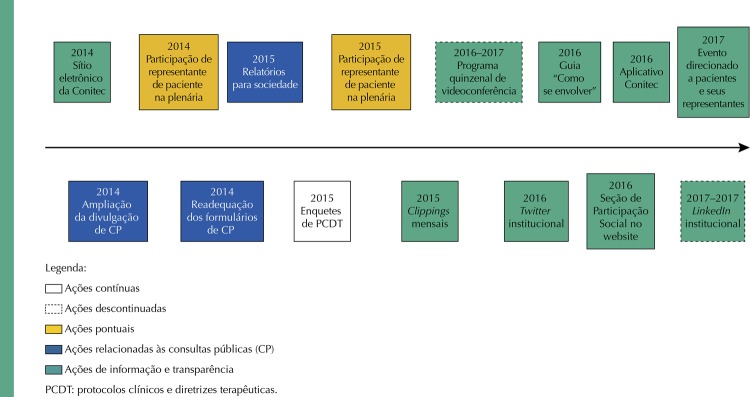
Linha do tempo das ações de envolvimento do público e do paciente nos processos de avaliação e incorporação de tecnologias no SUS desenvolvidas desde a criação da Conitec até dezembro de 2017. Fonte: Conitec, 2018.